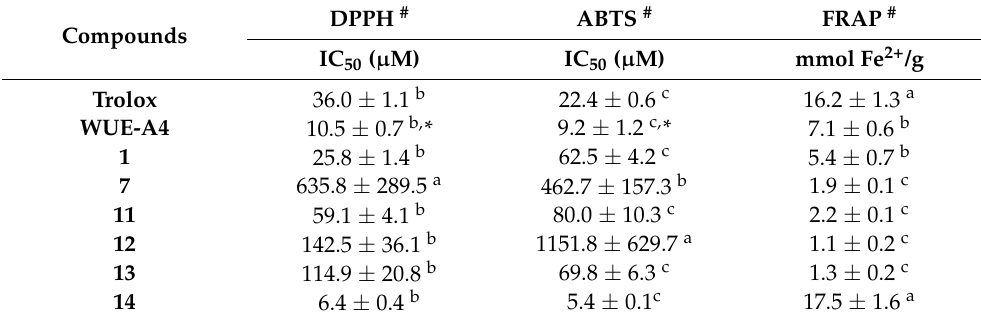
Table 4. Antioxidant activities of compounds isolated from WUE-A4 tested by DPPH, ABTS, and FRAP assays.